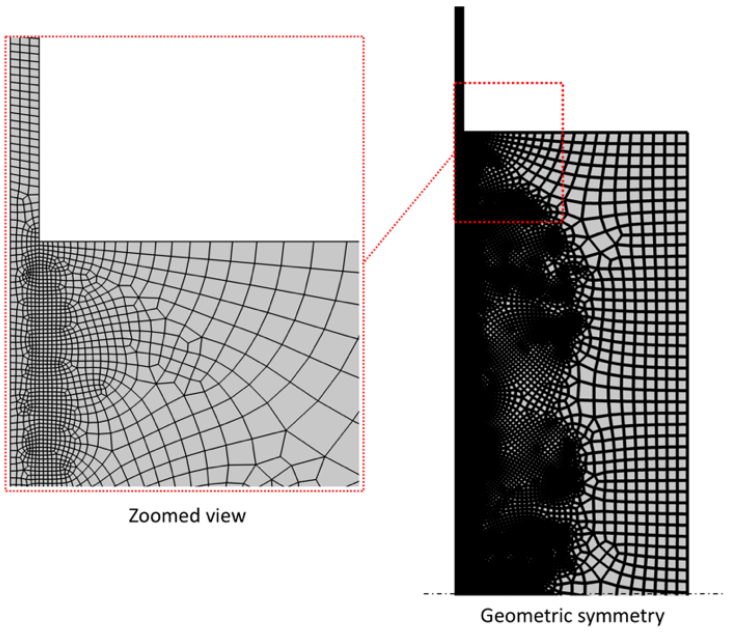
Figure 7. Finite element discretization of the SMA–polymer sample by 2D four-node axisymmetric quadrilateral elements.